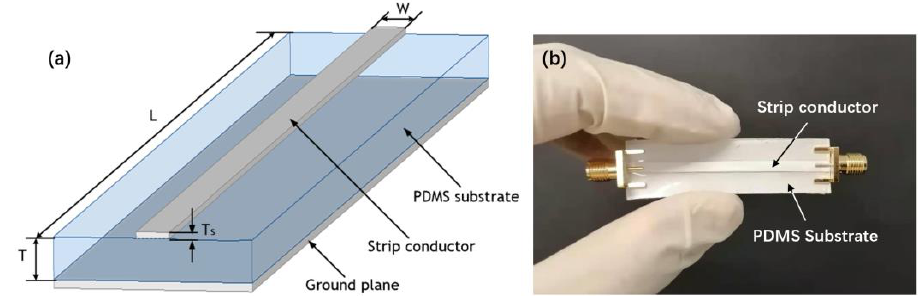
Figure 1. ( a ) The structure of the microstrip line, and ( b ) e photograph of a microstrip sample with sub-miniature-A (SMA) connectors, and the ground plane is on the other side of the transparent polydimethylsiloxane (PDMS)